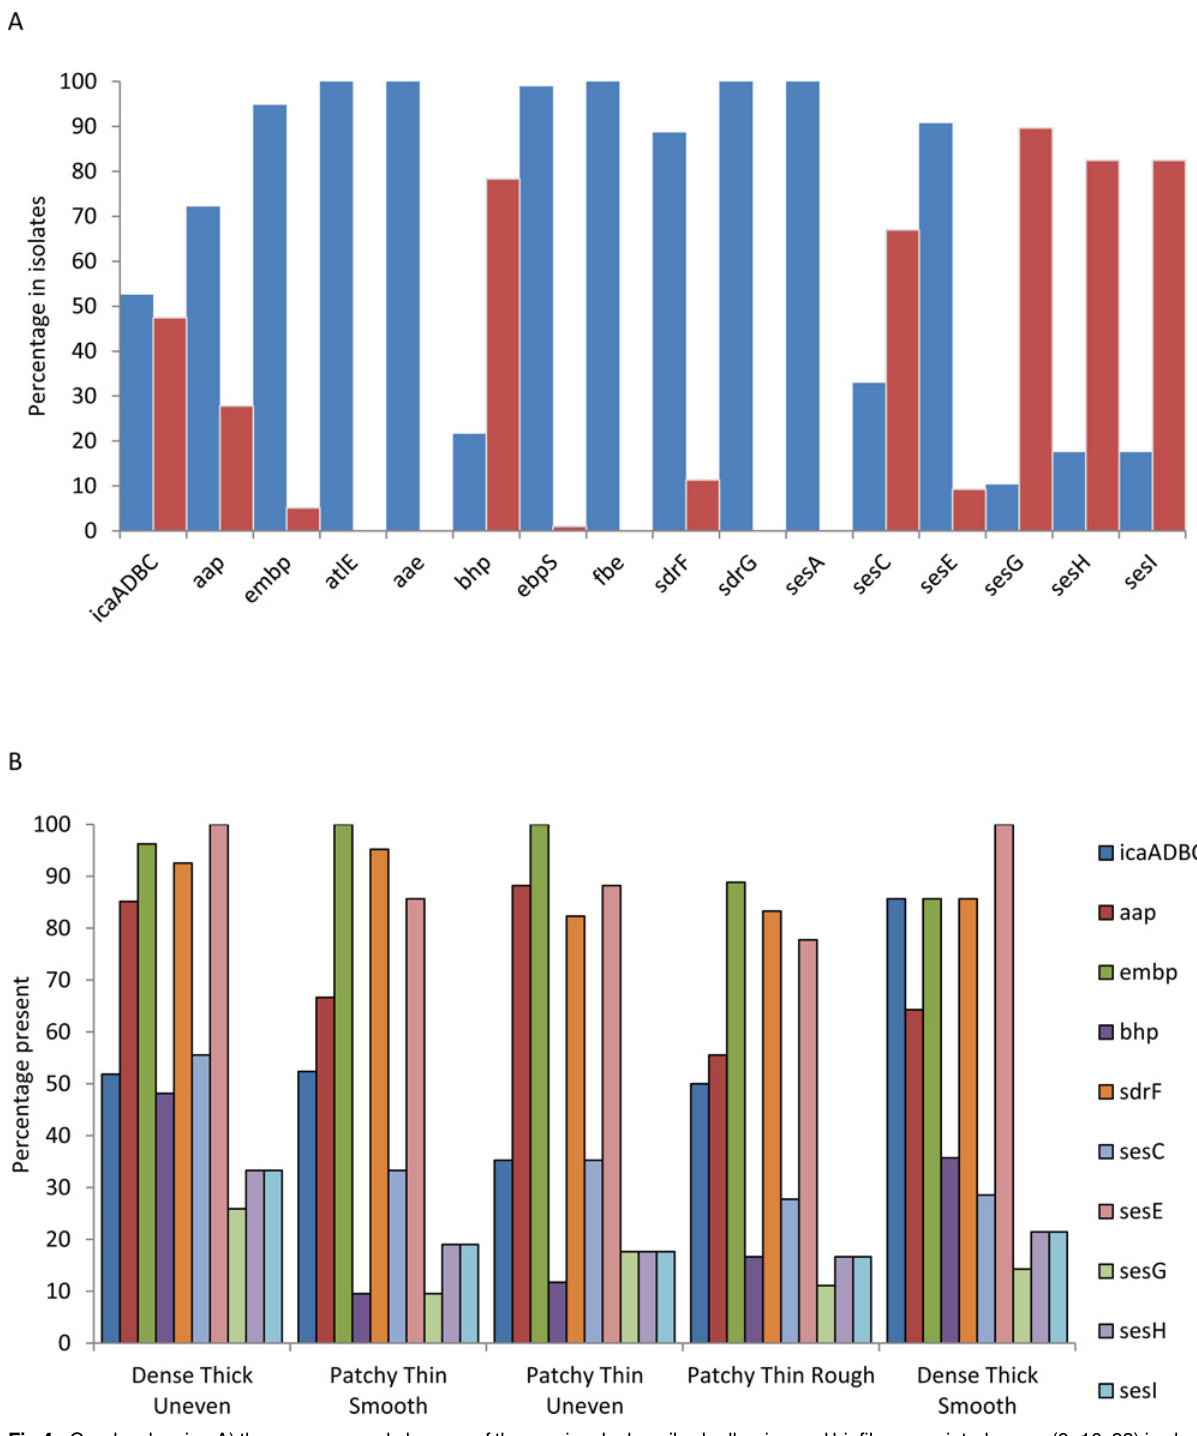
Fig 4. Graphs showing A) the presence and absence of the previously described adhesion and biofilm associated genes (9 – 16, 33) in clade A isolates, present (blue), absent (red); and B) percentage genes present in the isolates based on the 5 biofilm morphotypes.